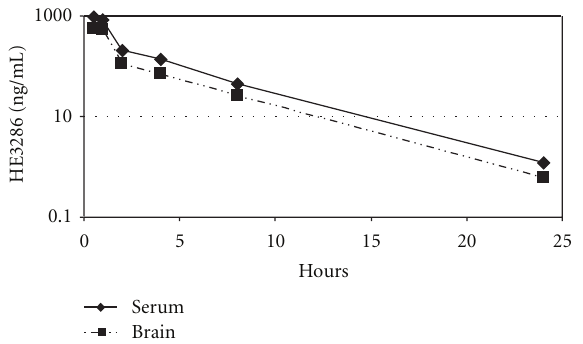
Figure 1: HE3286 readily penetrates the BBB. CD-1 mice (males, n = 3 per group) were treated (gavage) with HE3286 (80mg/kg HE3286) and sacrificed at 0.5, 1, 2, 3, 4, 8, and 24h. Serum and brain samples were analyzed for HE3286 by LC-MS/MS. Each point represents the mean value derived from three animals.